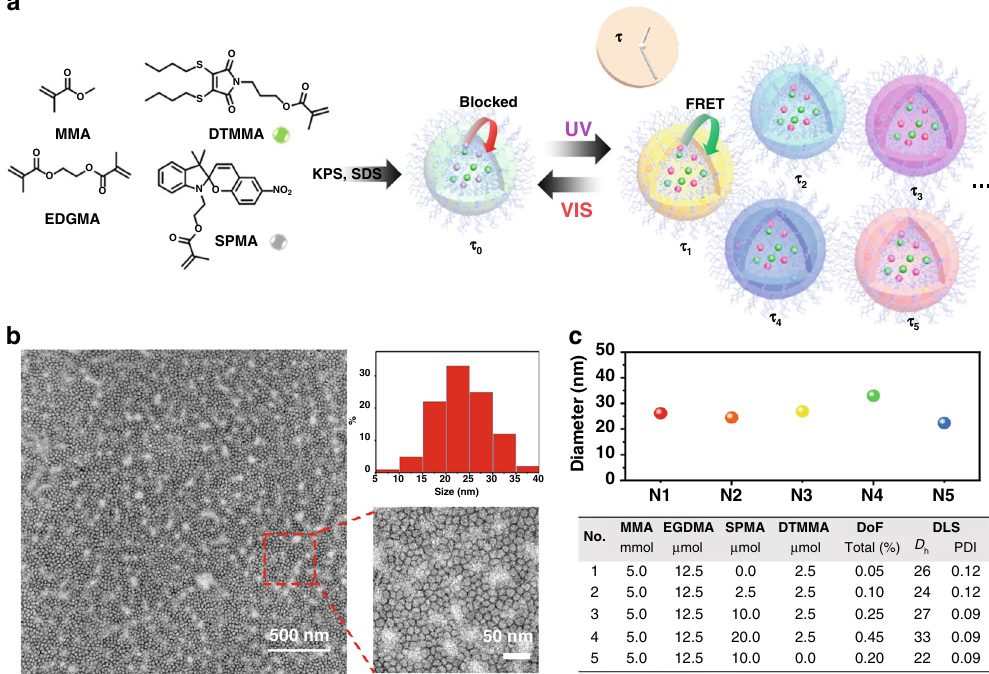
Fig. 1 Fabrication of the photo-switchable polymeric nanogels. a Schematic representation of the preparation of light-triggered fl uorescence lifetime switchable nanogels via emulsion polymerization; KPS: potassium persulfate; SDS: sodium dodecyl sulfate. b TEM micrographs of nanogel N4 (stained with 1 wt% uranyl acetate in water) illustrating the spherical morphology and histogram of observed size distributions; Scale bar: 500 nm (50 nm in zoomed region); Observed TEM sizes were collected from visualization of at least three separated samples; c Size distributions and corresponding hydrodynamic diameters of nanogels with variable SMPA and DTMMA ratios, obtained by DLS (detection angle = 173°) carried out in water at 25 °C (DoF = degree of functionalization, D h = hydrodynamic diameter, PD = polydispersity). All determinations were repeated four times with 15 measurements recorded for each